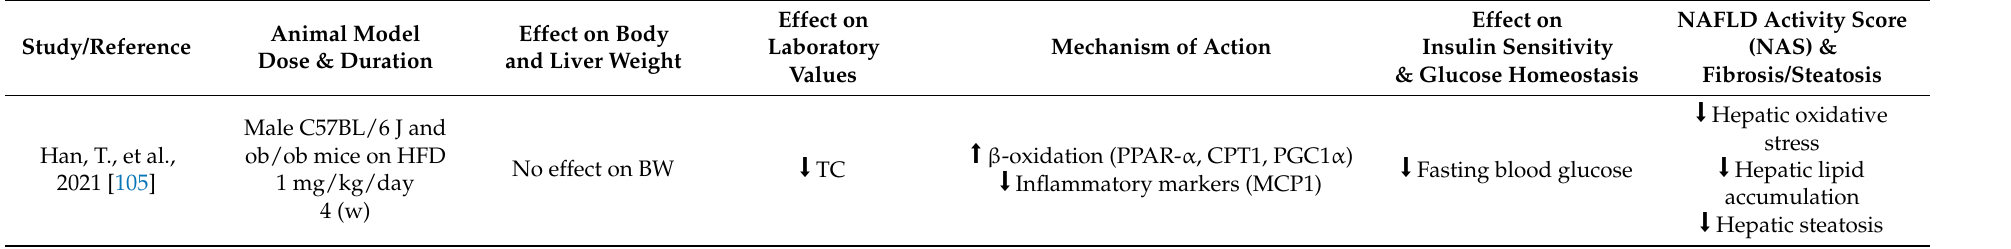
Table 1. Key animal studies regarding the impact of empagliflozin on NAFLD/NASH.